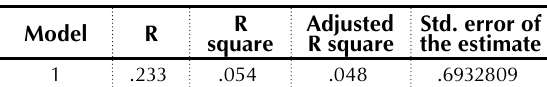
Table 6. Results of the coefficient determination test